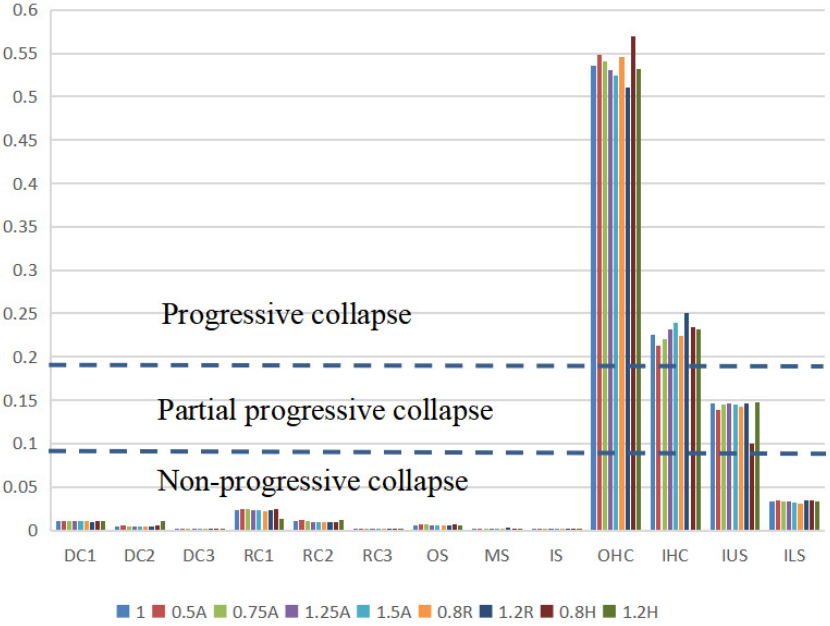
Figure 13. Importance coefficients of the structural elements under different cross ‐ sectional areas of cables, radii of the IHC and lengths of the cables, radii of the IHC and lengths of the MS .